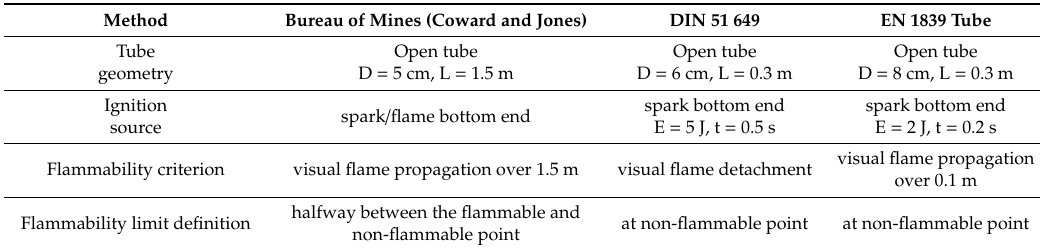
Table 2. Comparison between standardized methods to determine the flammability limit. Reproduced from Ref. [31], KU Leuven: 2007.